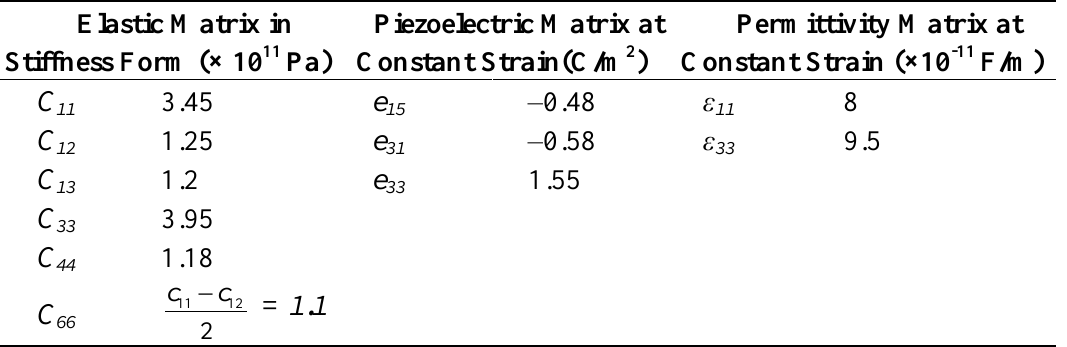
Table 1. Material properties of Aluminum